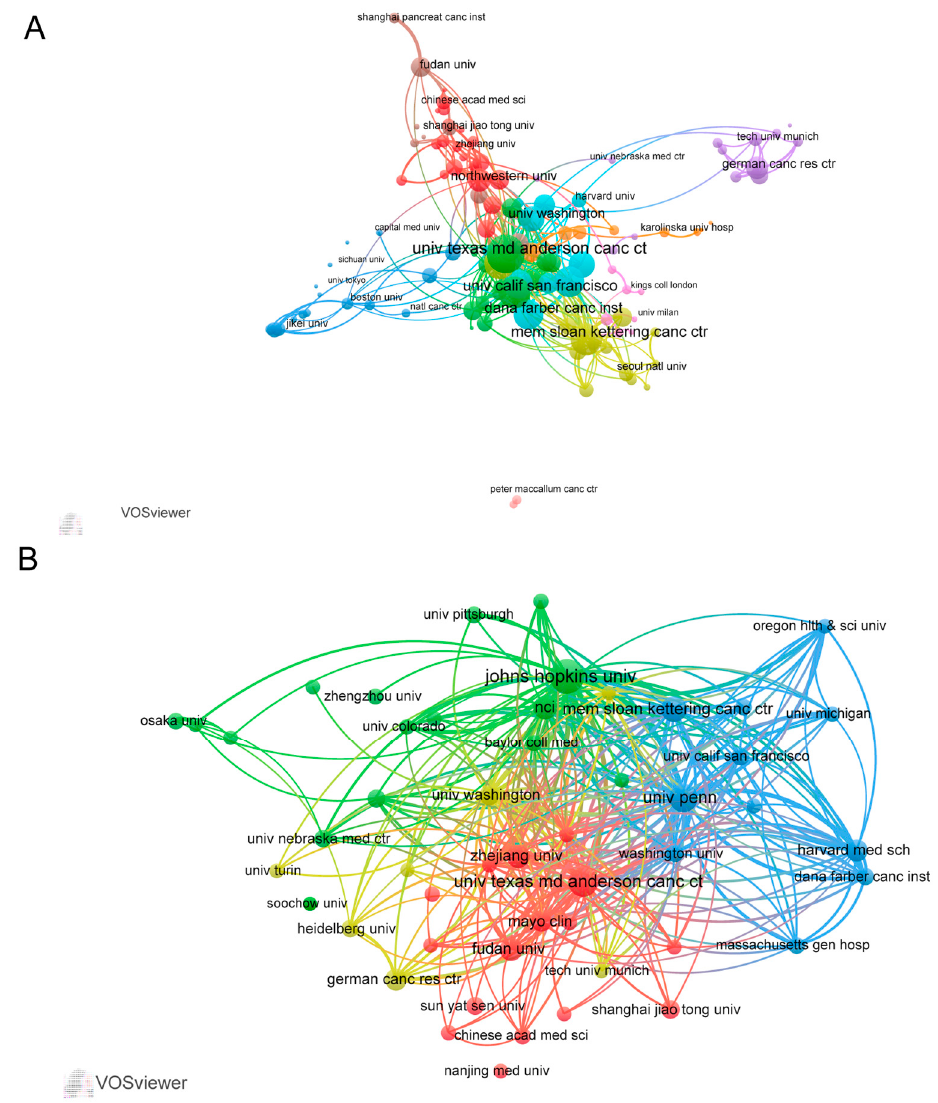
Figure 3. ( A ) The cooperation map of institutions performed with VOS viewer. The size of nodes represented the number of publications, while the thickness of the lines indicated the collaboration strength. ( B ) The citation network of institutions created with VOS viewer. Table 2. Top 10 productive institutes.